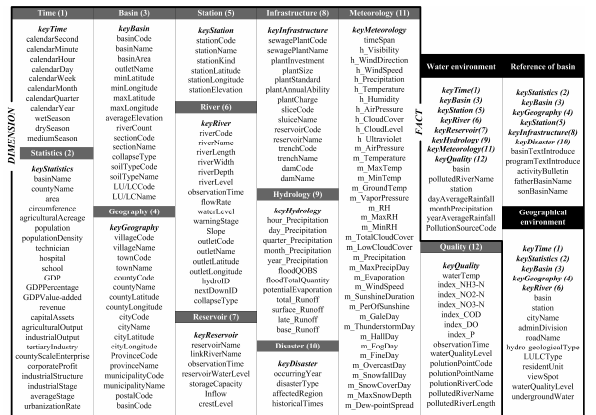
Figure 2. The fact and dimension table of data warehouse